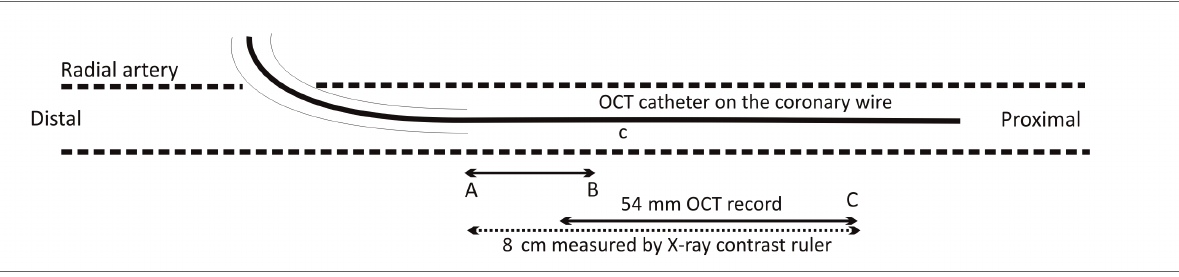
Fig. 2. optical coherence tomography of ra – procedure scheme.